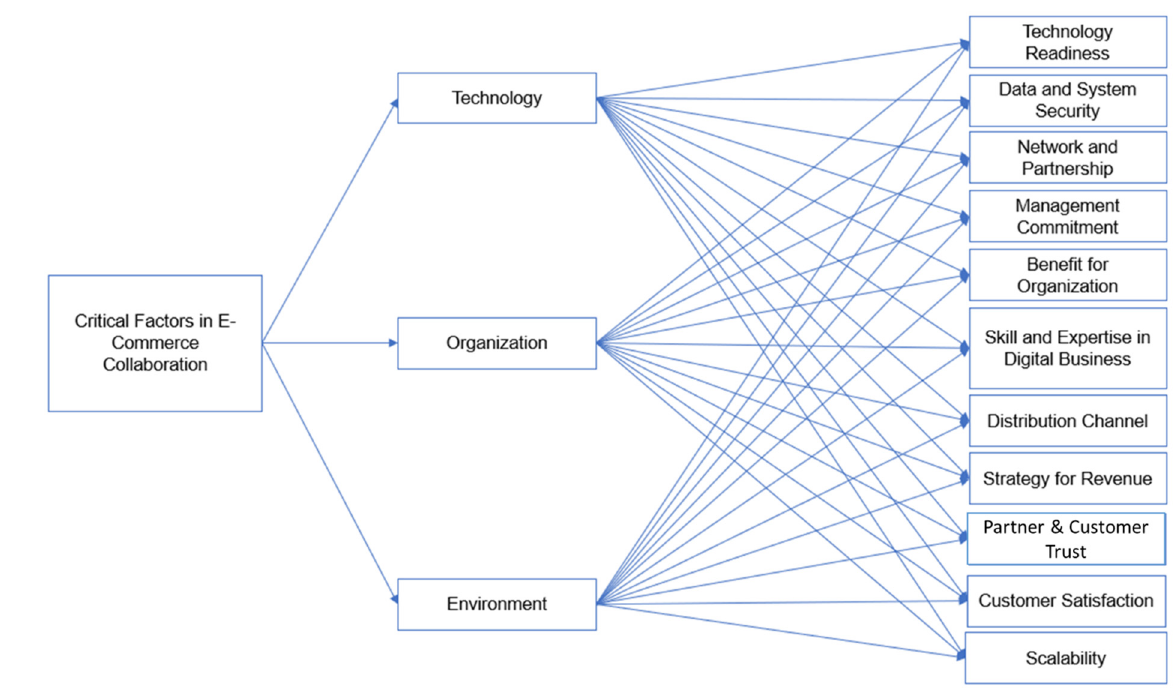
Figure 2. Hierarchy of CSF based on the TOE framework.